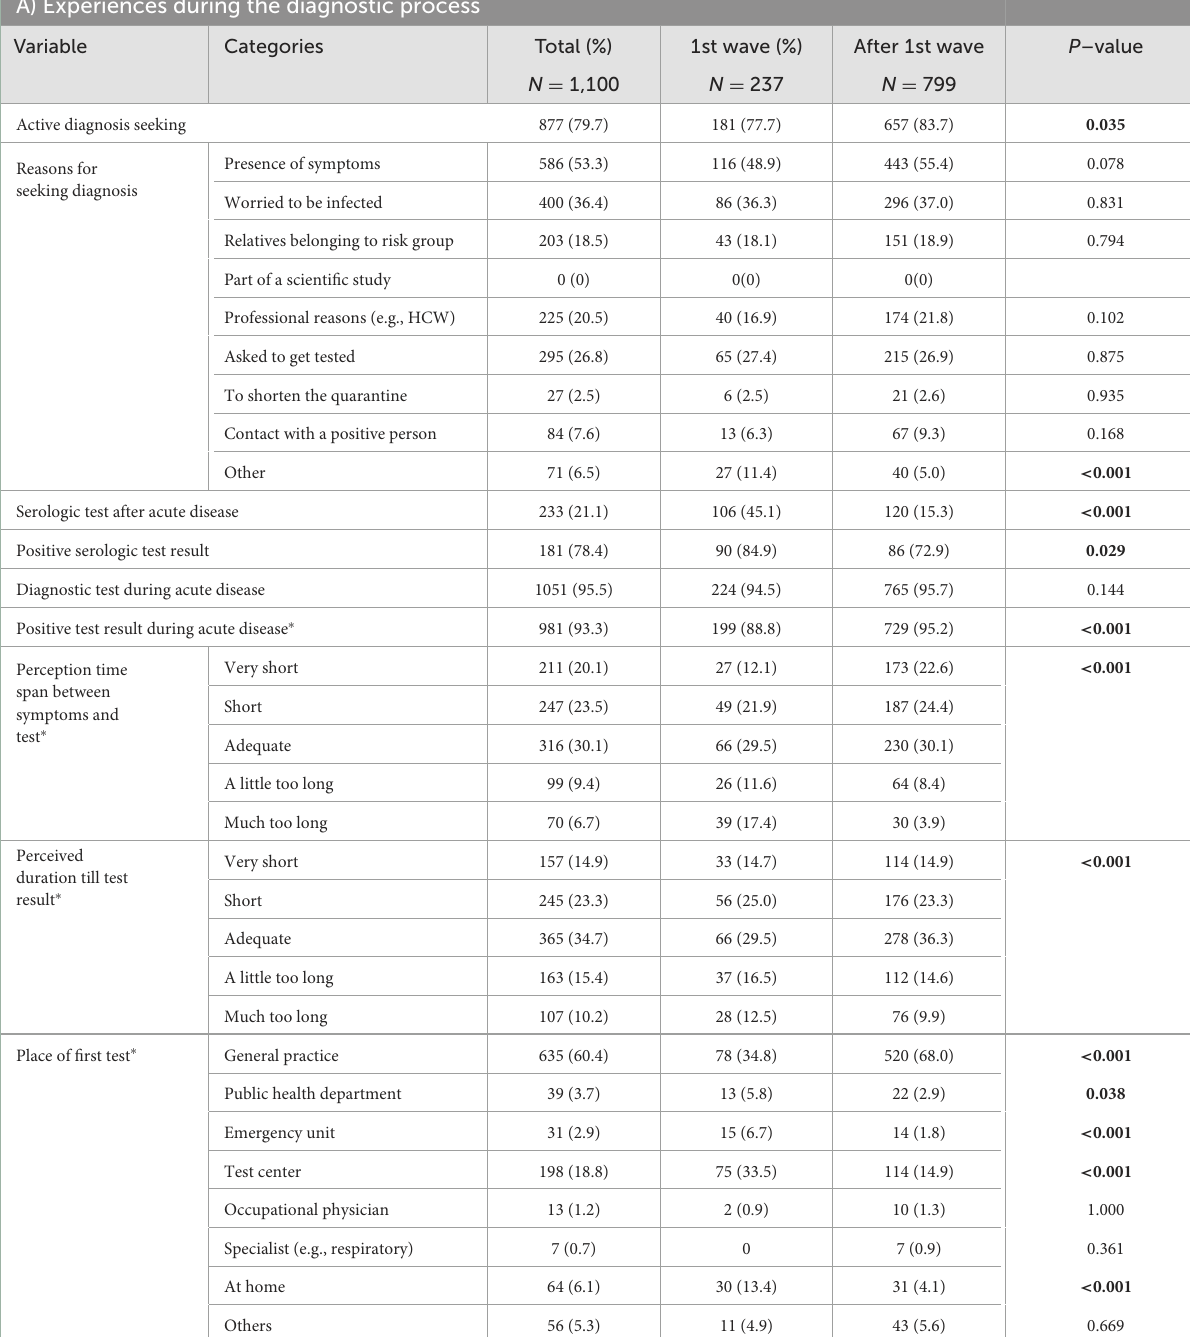
TABLE 2 Experiences of people affected by acute COVID − 19, summary of quantitative